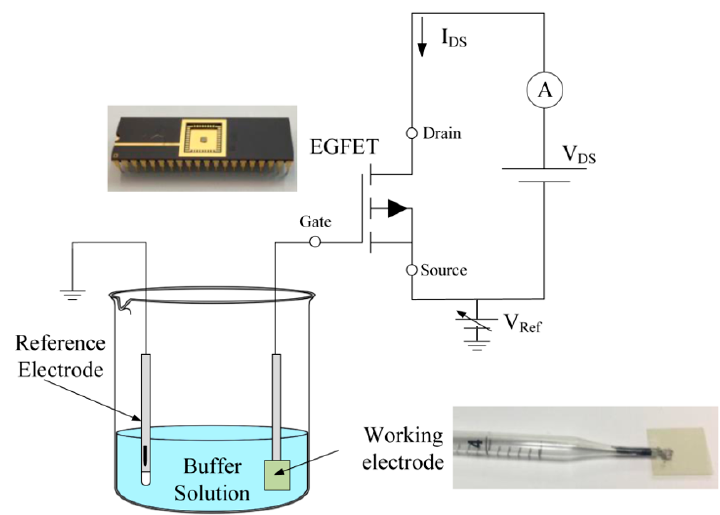
Figure 3. Schematic of the EGFET experimental setup.